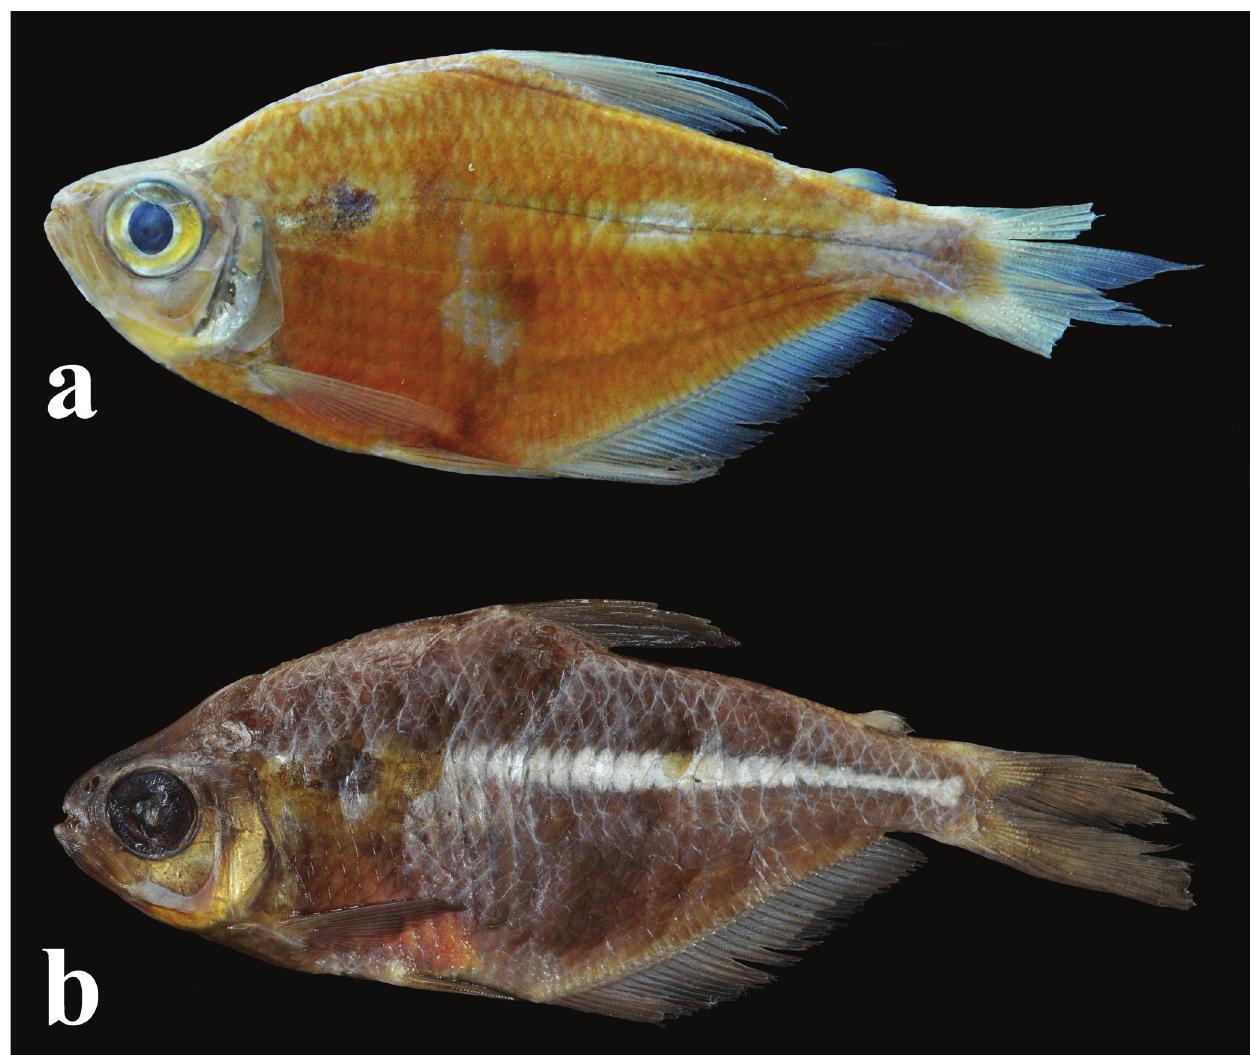
Fig. 1. Tetragonopterus doceanus , syntypes, (a) MHNH 1913.136, 62.2 mm SL, and (b) NMW 57391, 83.8 mm SL, rio Doce,